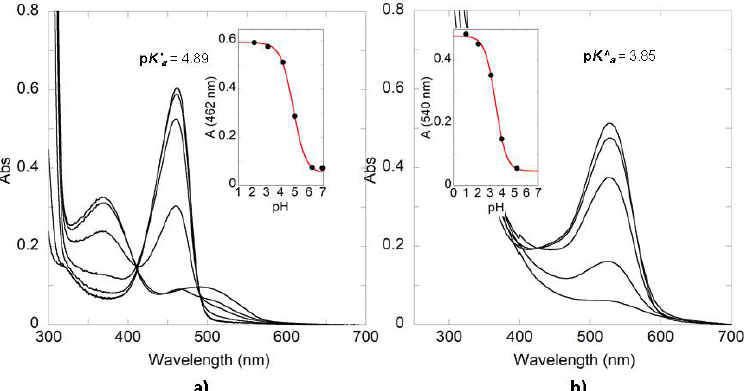
Figure 7. UV-Vis spectral variations of equilibrated and pseudo-equilibrated solutions obtained after direct pH jumps from pH=1 to higher pH values (citrate buffer 0.01M). ( a ) 4′7-DHF (1.15 × 10 −5 M) in presence of SC4 46 mM and ( b ) Oenin (1.7 × 10 −5 M) in presence of SC8 6.5 mM. The insets show the fitting for the calculation of p K’ a or p K ^a .